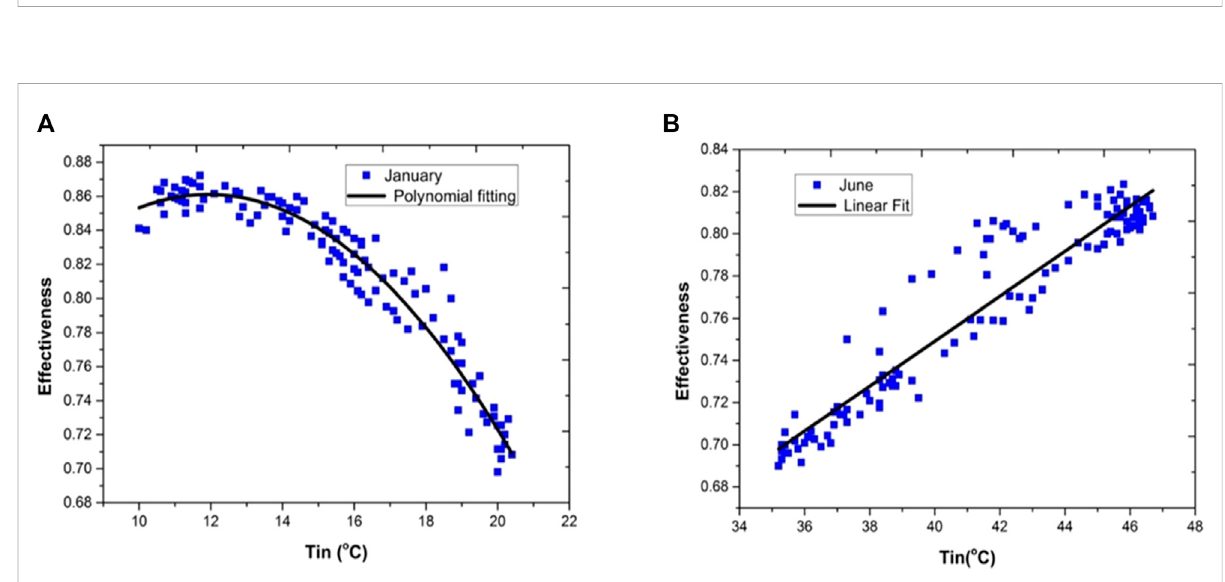
FIGURE 10 Variation of effectiveness with inlet air temperature during (A) January and (B)